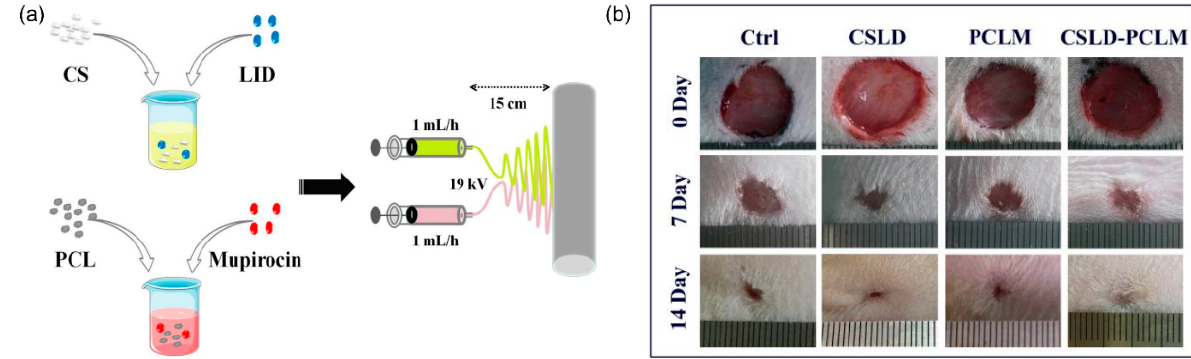
Figure 20. ( a ) Fabrication process of CSLD-PCLM NF scaffolds. ( b ) Wound healing effect of CSLD-PCLM NF scaffolds in a full-thickness skin defect model. Reproduced with permission from [118], Copyright © 2021, American Chemical Society.